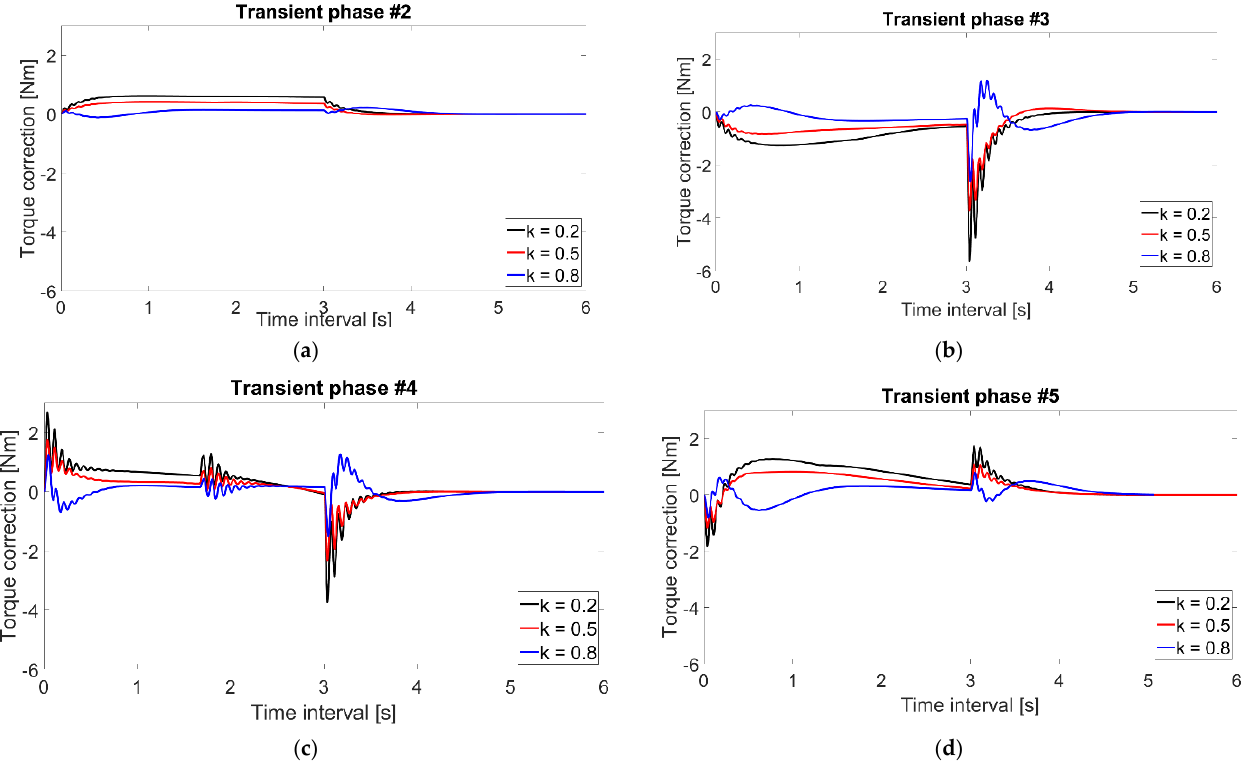
Figure 9. Details of coordination during transients: ( a ) Transient #2, ( b ) Transient #3, ( c ) Transient #4, and ( d ) Transient #5. Table 3. Overshoot and settling time of Transient #3 vs. electric contribution ( k